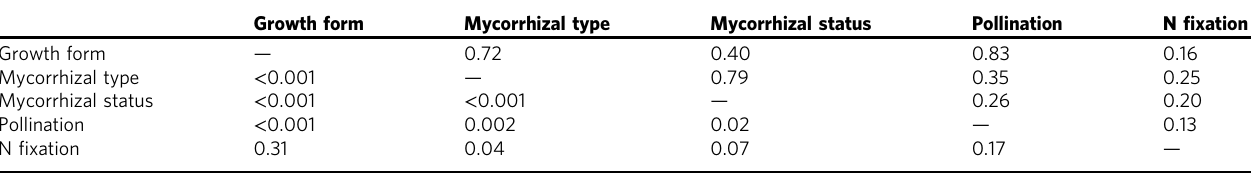
Table 1 Correlation between mutualist traits and growth form in a taxon list of 131 plant MOTUs recorded in northern high- latitude permafrost samples